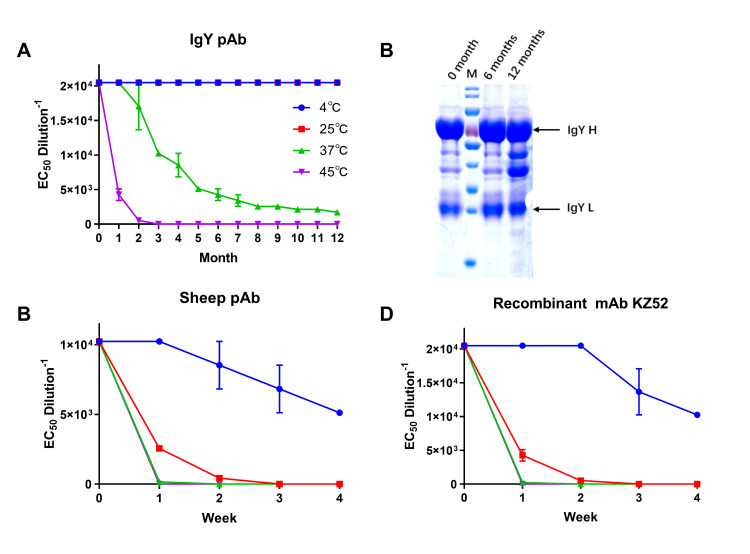
Thermal stability analysis of IgY pAb, sheep pAb and recombinant mAb against EBOV.Three different types of antibody solutions were placed under different temperature conditions (4°C, 25°C, 37°C, and 45°C) for 1 year or 4 weeks and NAb titers were detected per month (A) or week (C, D). The IgY stored at 25°C for 0, 6 and 12 months were analysed by SDS-PAGE (B). Data are shown as means ± SEM.